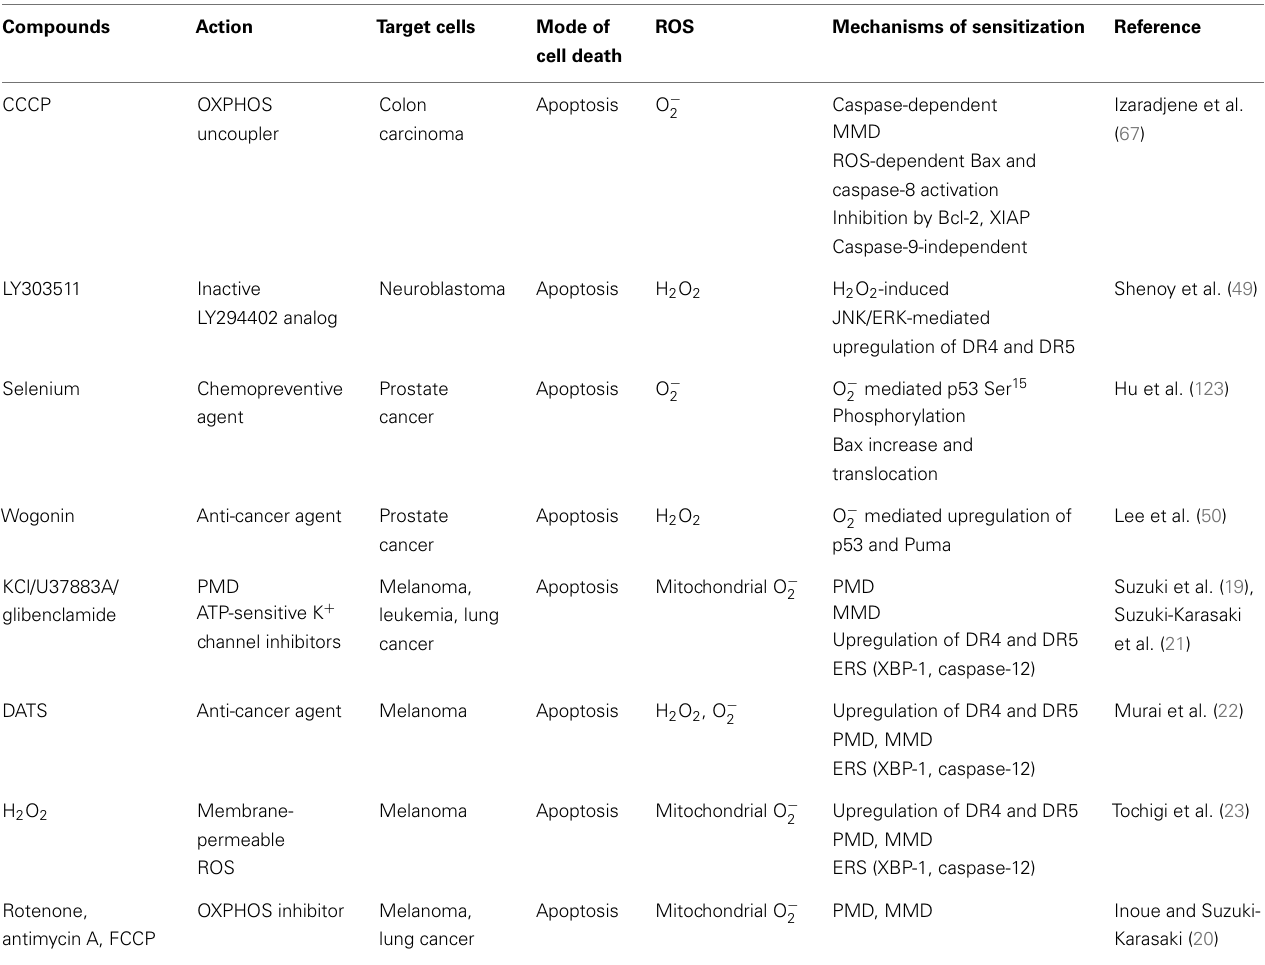
Table 3 | Reactive oxygen species-generatingTRAIL sensitizers